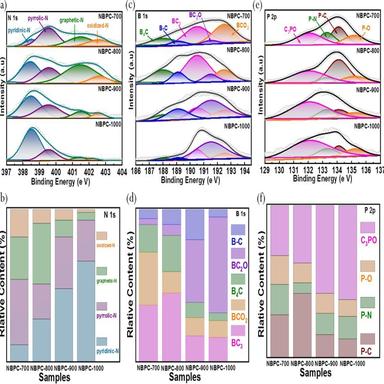
(a) Deconvolutions of N 1 s and (b) content of different N species; (c) B 1 s XPS spectra and (d) content of B species; (e) P 2p spectra and (f) content of P species of NBPC-700, NBPC-800, NBPC-900, and NBPC-1000.